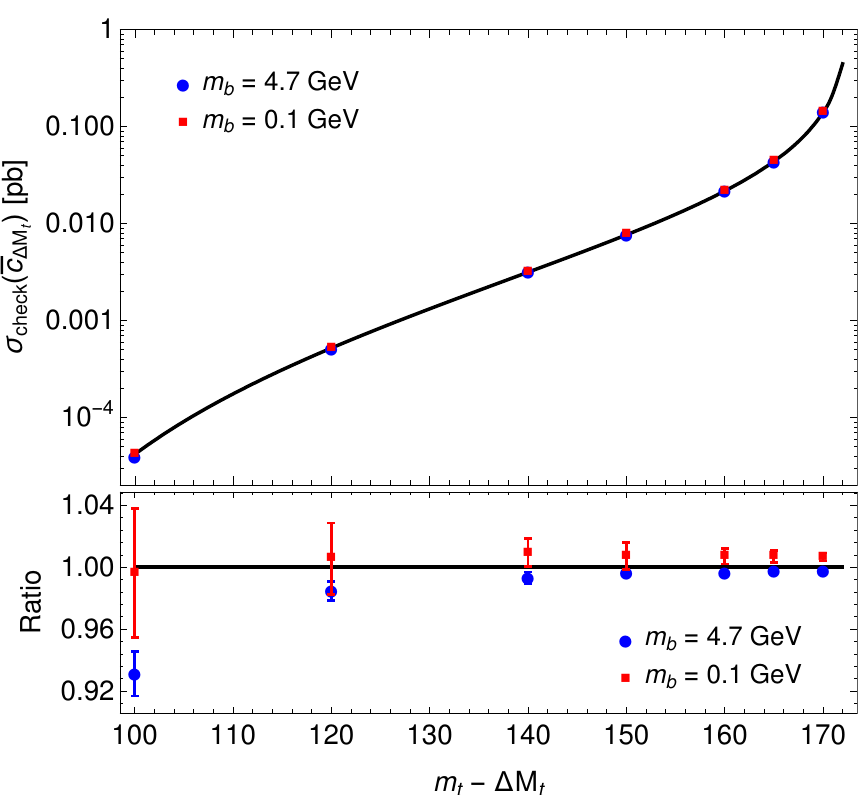
Figure 9 . Consistency check for various values for the complementary cut p 2 line in the upper panel is our semi-analytical result (6.1) for (cid:27) check ((cid:22) c (cid:1) M of the contributions from the tree-level diagram h 1 , the squared and the interference